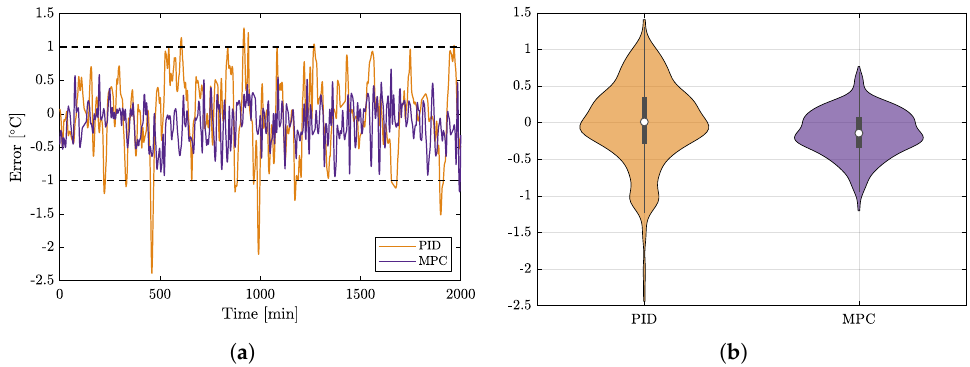
Figure 7. Performance comparison of PID and MPC-based control loops. ( a ) Timeseries showing the dynamics of set-point tracking error; the maximum tolerable deviation from the set point is ± 1 ◦ C, the closer the values are to zero, the better. The PID-based control loop frequently escapes the allowed error band. ( b ) Violin plots showing the distributions of deviations from the set point. It can be clearly seen that the MPC-based control loop results in a set point deviation that is more tightly packed around the origin, thus demonstrating the benefit of this control configuration compared to the PID control loop. ( a ) Timeseries showing the deviations from the set point for the compared control algorithms. ( b ) Violin plots for the set point deviations’ distributions for the compared control